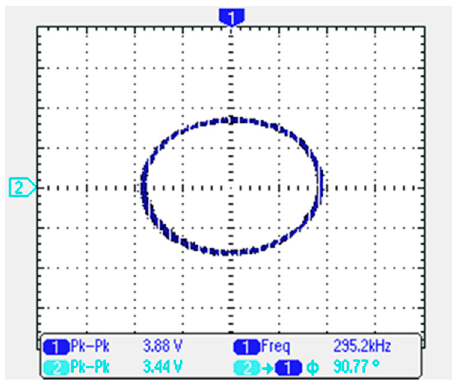
Figure 16. The experimental result for X – Y plot of V o 1 and V o 2 outputs in Figure 15.